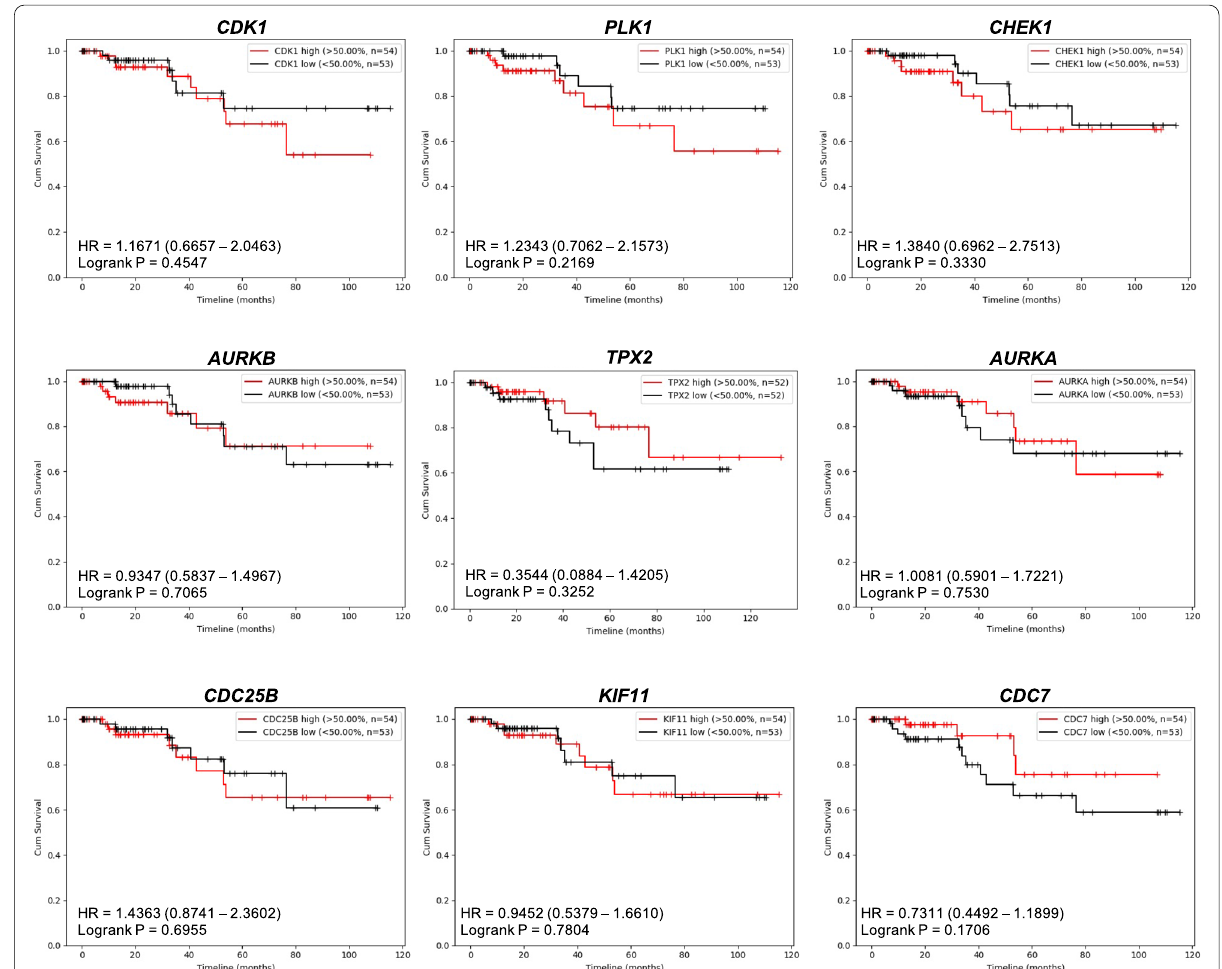
Fig. 6 The disease‑free survival analysis from AURKB , PLK1 , CDK1 , TPX2 , AURKA , KIF11 , CDC7 , CHEK1 , and CDC25B genes in triple negative breast cancer